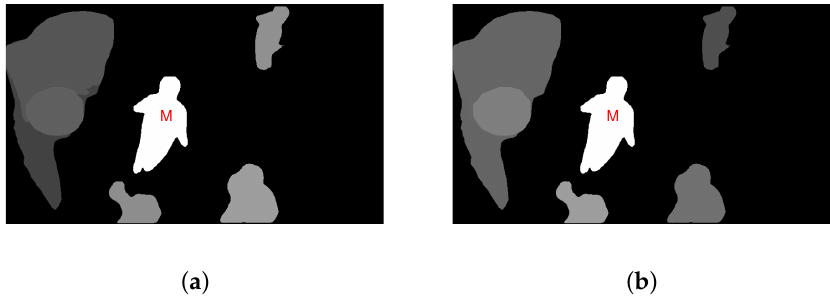
Figure 6. ( a ) The traditional central bias map; ( b ) The modified central bias